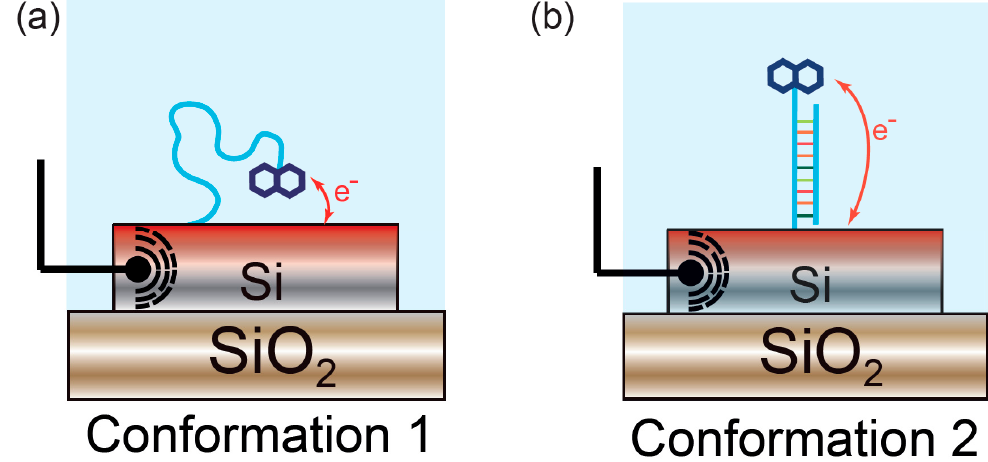
Figure 7. Monitoring of conformational changes with electro-photonic silicon biosensing. ( a ) Single-stranded DNA is immobilised on the sensor surface. A redox active probe linked to the DNA oligonucleotide enables electrochemical measurement of DNA hybridisation; ( b ) Upon binding to its complementary strand, the surface-immobilised DNA strand undergoes a conformational change, displacing the electrochemical probe away from the surface. This modifies the thermodynamics of the electron-transfer process, hence exhibiting changes in the electrochemical response. This conformational change can simultaneously be monitored in real-time and quantified using the underlying silicon photonic